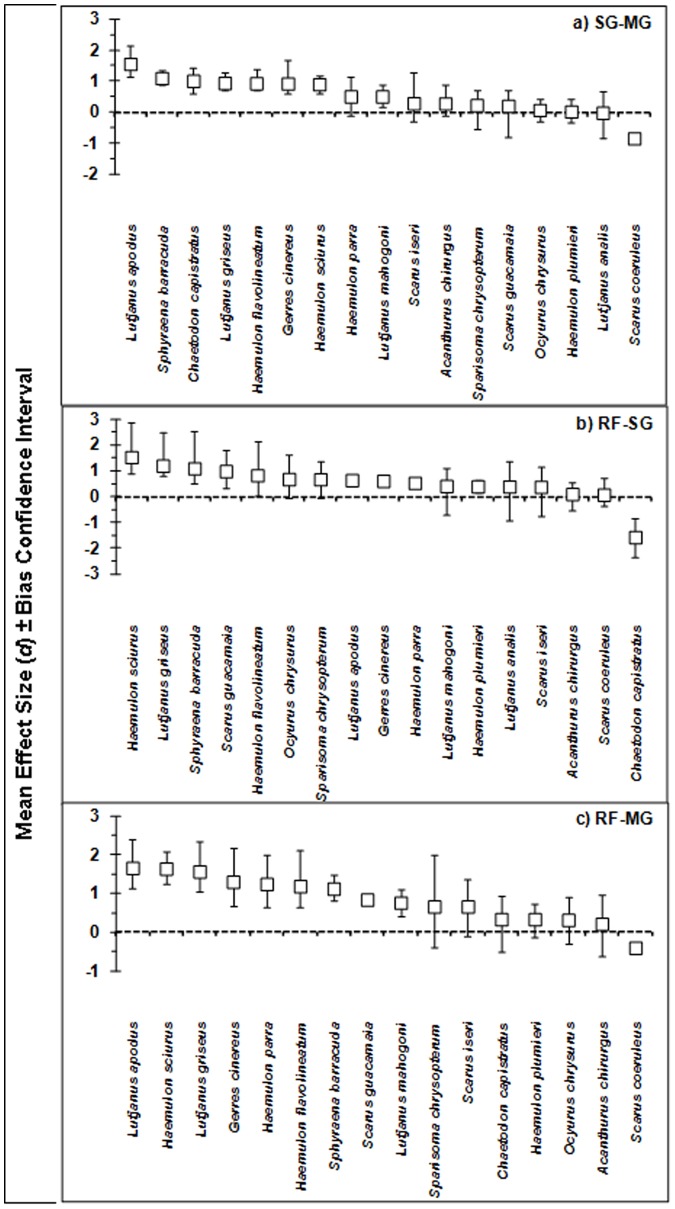
Rank-order of species-specific habitat utilization patterns based on the weighted mean effect size (d+) ± bias-corrected 95% confidence interval (based on variability across study locations) for the Caribbean region for a) seagrass (SG) – mangrove (MG) comparison, b) coral reef (RF) – seagrass comparison, and c) coral reef – mangrove comparison.If confidence intervals do not cross the vertical line at d = 0, the effect size is significant.